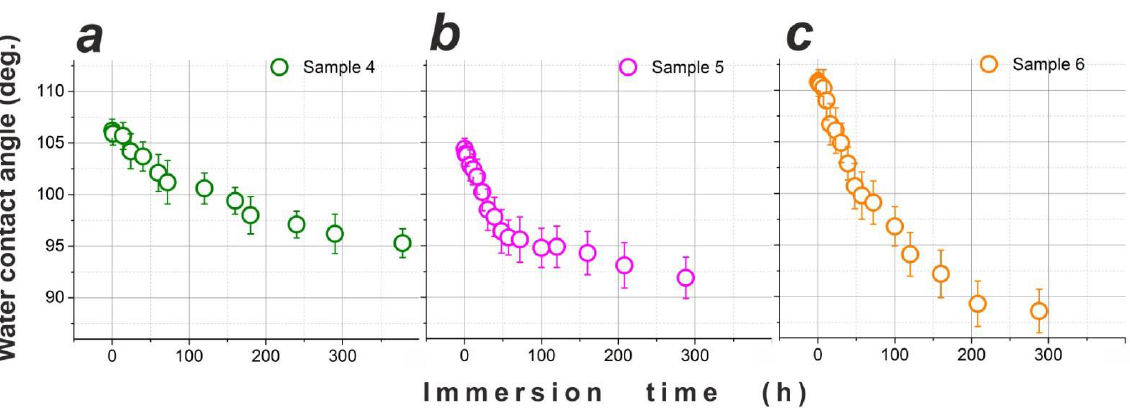
Figure 6. Wettability of samples 4 ( a ), 5 ( b ), and 6 ( c ) immersed in DI water for long time. Water CA values are shown as they evolved for as long as ~300 – 400 h of immersion.